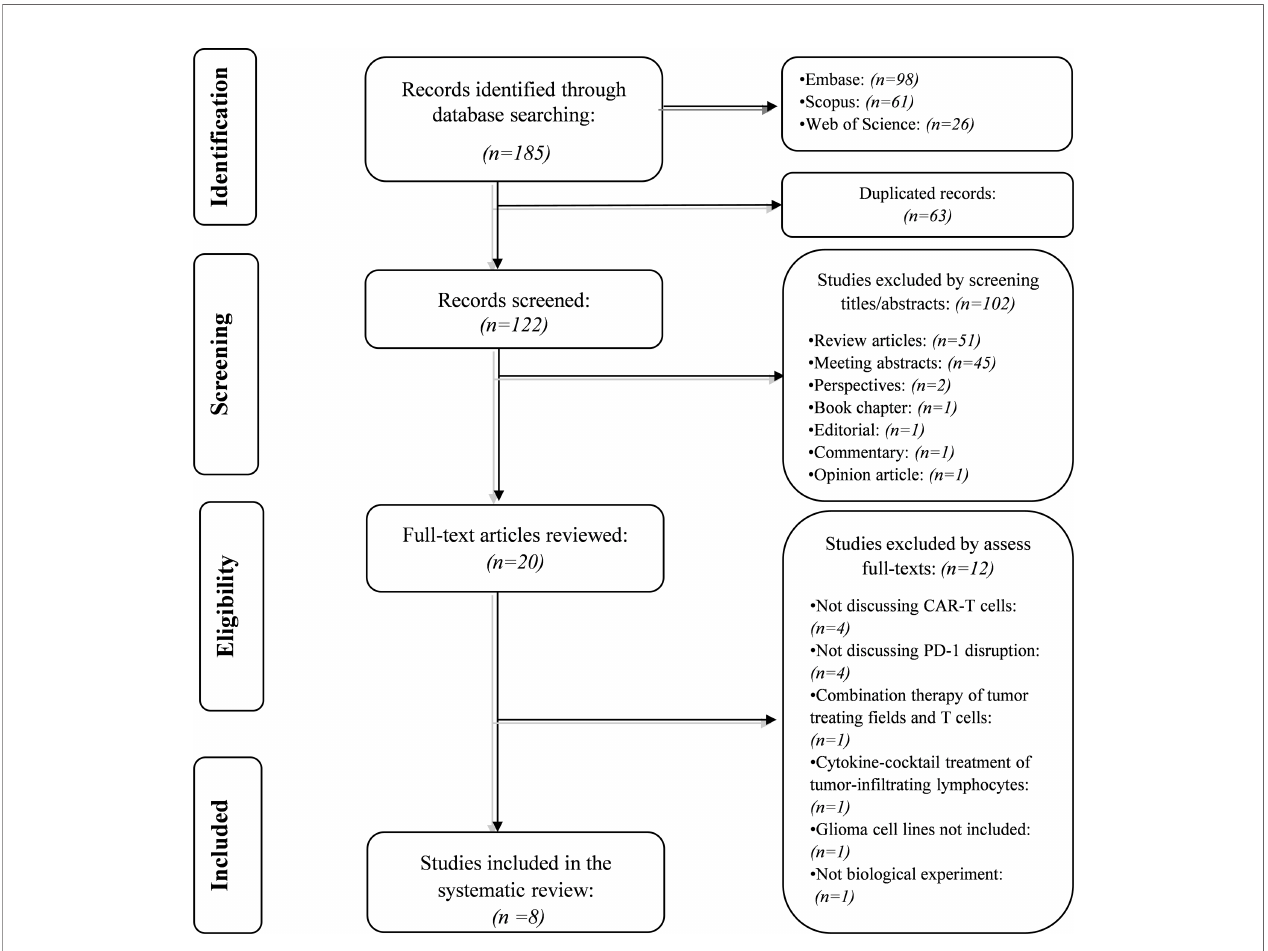
FIGURE 1 | The fl ow chart of the current